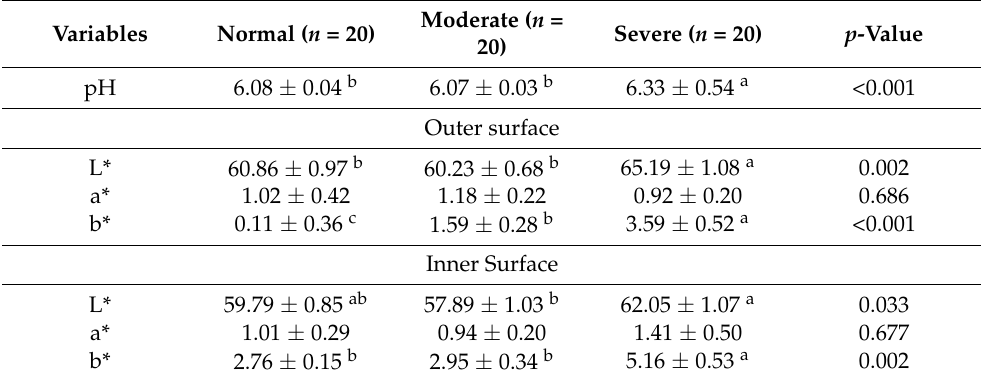
Table 2. Mean values and standard deviation of luminosity (L*), intensity of red (a*) and yellow (b*) of the breast meat of broilers affected by